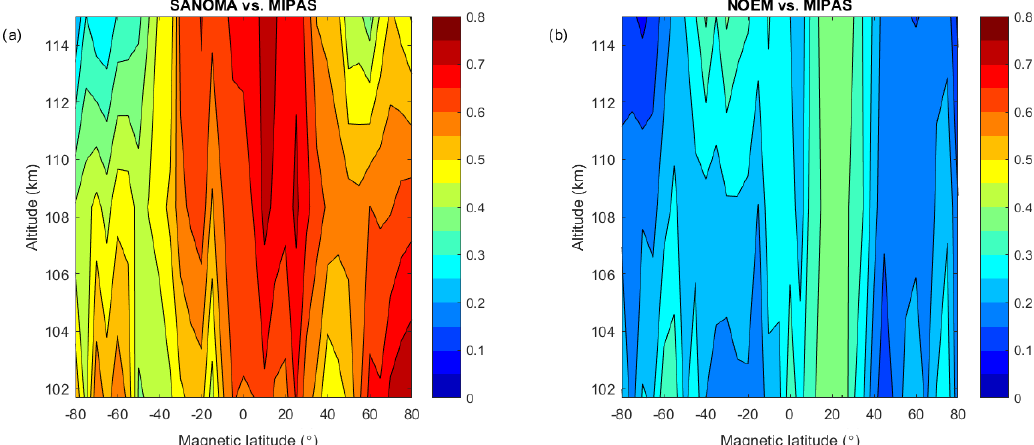
Figure 24. (a) Adjusted R 2 of a linear fit between SANOMA and MIPAS NO number density. (b) Adjusted R 2 of a linear fit between NOEM and MIPAS NO number